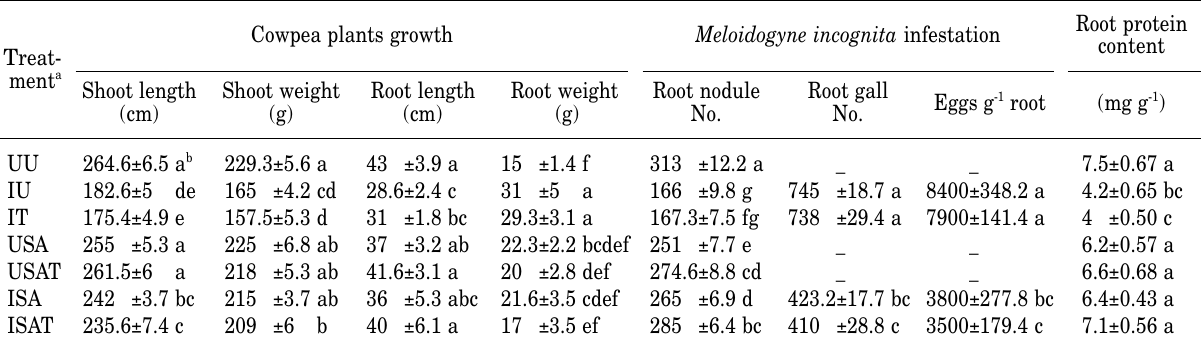
Table 1. Increase in cowpea growth, decrease in Meloidogyne incognita infestation of cowpea and root protein con- tent following treatment by exogenous salicylic acid at a 10 mM